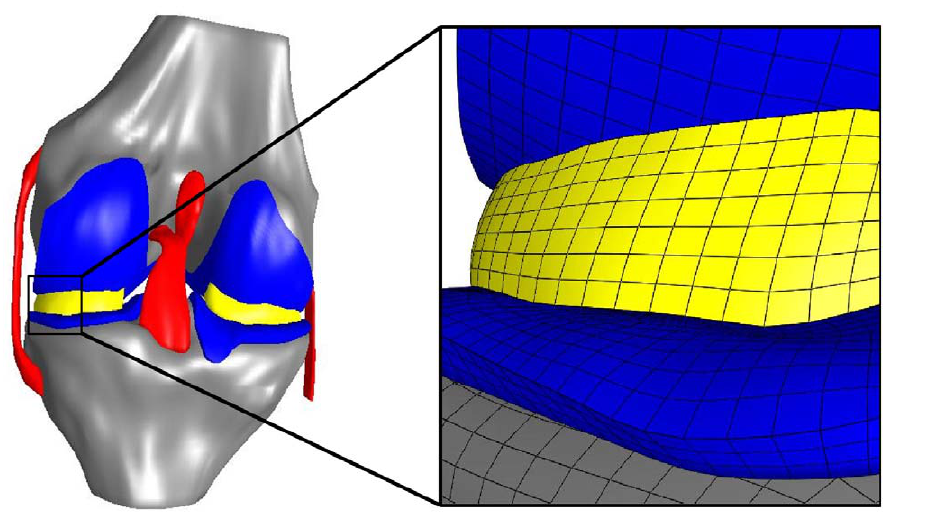
Figure 3. A finite element model of the tibiofemoral joint with representation of ACL, PCL, MCL, LCL, tibial and femoral cartilage, lateral and medial menisci, femur, and tibia. Soft tissue structures were discretized with 56433 linear hexahedral finite elements with an average edge length of approximately 1mm . The bones were discretized with 25220 quadrilateral shell elements with an assigned thickness of 1mm . An enlarged model region is shown on the right to illustrate the mesh resolution. The femoral and tibial cartilage each had 3 hexahedral elements through their thickness.